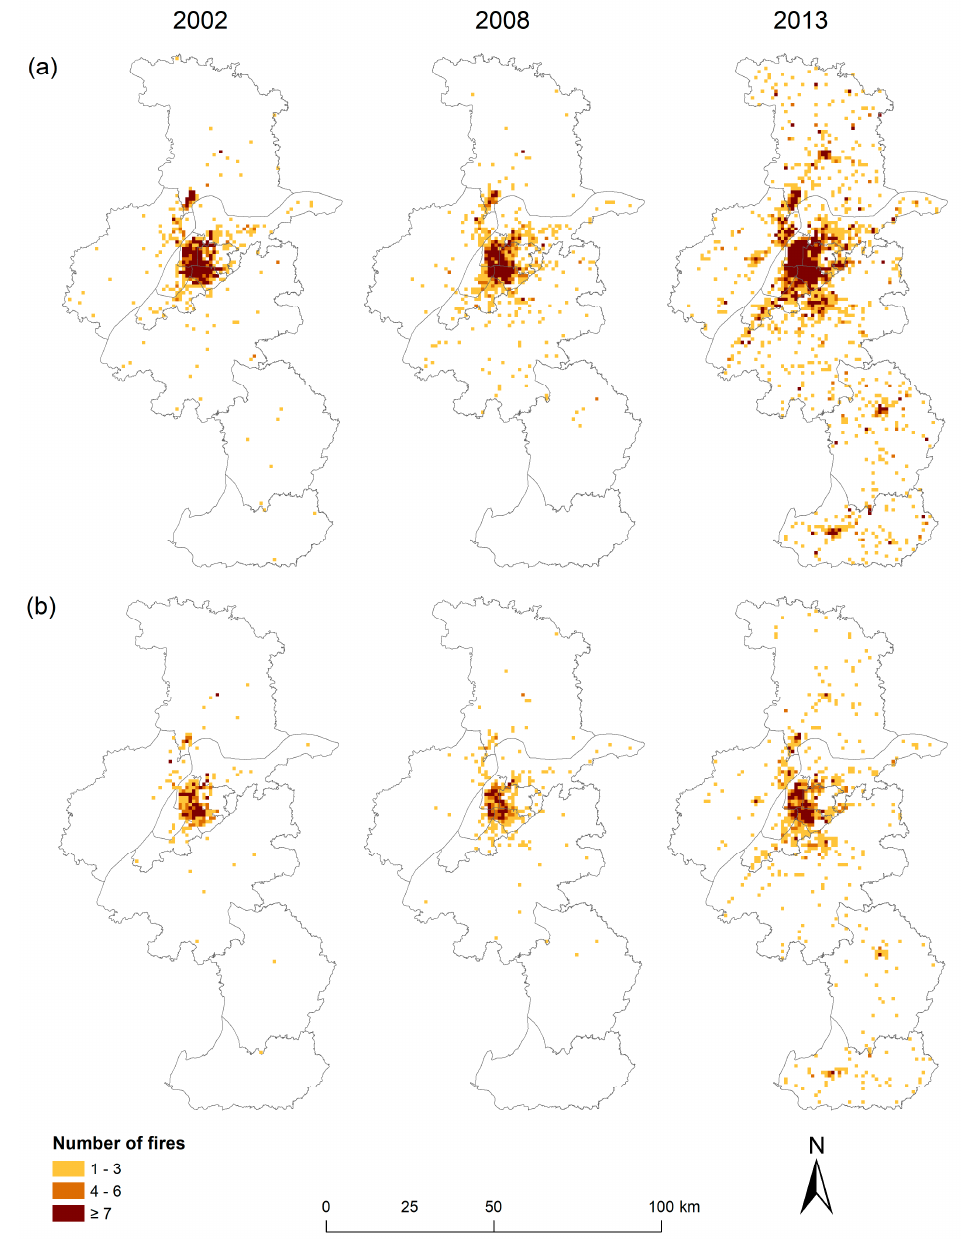
Figure 6. Spatial distribution of fire incidents: ( a ) total fire and ( b ) dwelling fire.